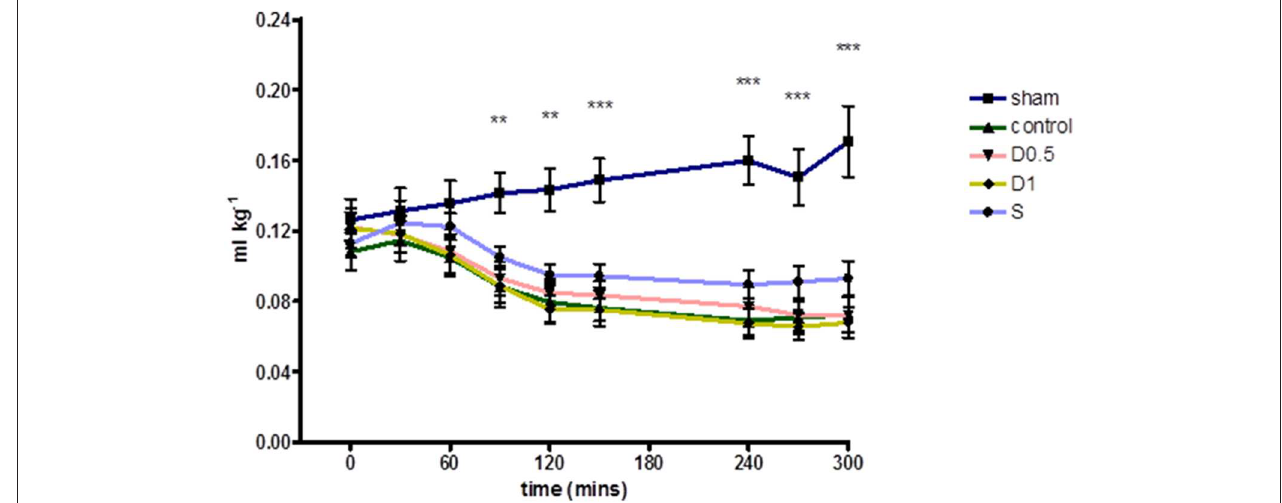
FIGURE 1 | Relative Stroke Volume Index during 5h of laparotomy and endotoxemia recorded every 30min. Values not plotted for t180–t210 [animals were undergoing IVM at this time and aortic flow and HR could not be measured (therefore relative SVI could not be calculated)]. Relative stroke volume index in controls differed significantly for most of the experiment and until its end when compared to shams. However, no significant differences in relative stroke volume index were observed between controls and groups treated with dopexamine or salbutamol at any time. The mean change in relative stroke volume index from baseline to end experiment was also significant in all groups except salbutamol treated animals (also see Table 1 ). Data presented as mean (SEM). One-way ANOVA at each time point (Bonferroni’s post-tests, ** p < 0.01, *** p < 0.001 vs. controls).